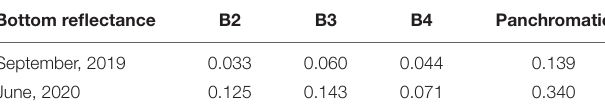
Sentinel-2A images. Bottom